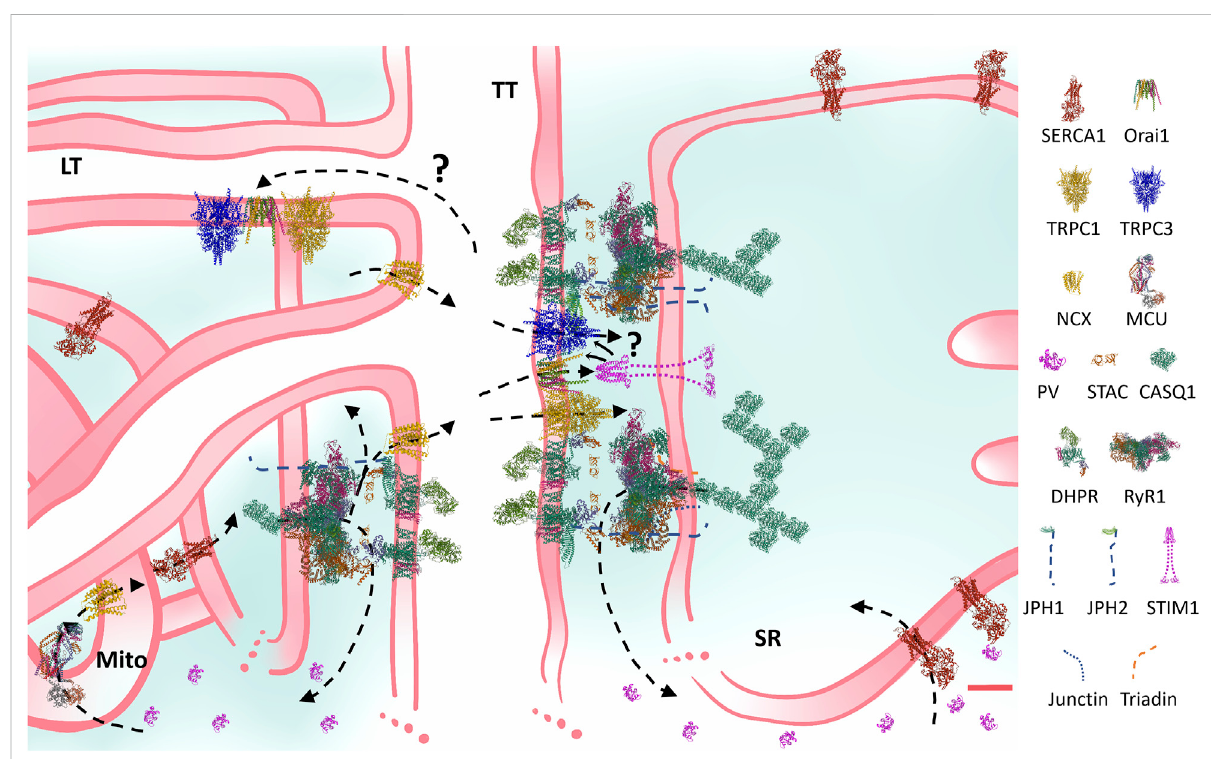
FIGURE 1 Structural and functional comprehensive model of the Ca 2+ handling machinery and Ca 2+ fl uxes of the mammalian skeletal muscle ECC. Constructed at scale based on microscopy and protein measurements, the cartoon considers many current observations and addressed the question if there is space for all ECC proteins in the triadic space. For instance, JPH-1 coprecipitates with RyR1 more than JPH-2, also, super- resolution observations suggest that JPH-1 locates more closely to RyR1 than JPH-2. Regarding the SOCE machinery, some TRPC members have been shown to precipitate with DHPR and Orai. The model shows that a TRPC-Orai-TRPC cluster explaining these observations fi ts among DHPR-RyR1-emptysquares.STIMlocationandsizeenablesitsbindingtotheTRPC-Orai-TRPCcluster.Also,thispatternmayexplainhowTRPCmay be a mediator of the RyR1 involvement in SOCE regulation. It is clear that preassembled STIM-Orai clusters present a solution to the problem of severe movement restrictions in this region. Arrows indicate Ca 2+ fl uxes. The internal equilibrium of Ca 2+ entails short (on the right: sarcoplasmic reticulum (SR) release, myoplasmic buffering and SERCA reuptake) and long (on the left: SR release, myoplasmic and mitochondrial (Mito) buffering and activation, and SERCA uptake) routes. The external equilibrium entails the Ca 2+ exit through the NCX and the entry through the SOCE channels, locatedinthetransverse(TT),andprobablyinthelongitudinaltubules(LT).Questionmarksindicateprobableroutesormechanisms,whichhave not been “ seen ” yet. Although thehighamount of PV was meantto represent atypeII fi bre,in general terms, thestructure and thedirectionof the fl uxes presented remain qualitatively the same in all fi bre types. In the few cases in which the structure of the muscle isoforms have not been determined, homologouswereused(e.g.,non-mammalianNCXorSTIM1wereusedinsteadofNCX1-3orSTIM1L).Keytothe fi gure:ECC:excitation-contraction coupling;SOCE:store-operatedCa 2+ entry;SERCA:sarcoendoplasmicreticulumCa 2+ adenosinetriphosphatase;TRPC:transientreceptorpotential canonical; NCX: Na + /Ca 2+ exchanger; MCU: mitochondrial Ca 2+ uniporter; PV: parvalbumin; STAC: SH3 and cysteine-rich domain containing protein; CASQ: calsequestrin; DHPR: dihydropyridine receptor; RyR: ryanodine receptor; JPH: junctophilin; STIM: stromal interaction